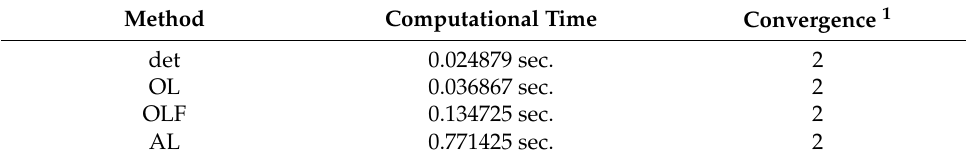
Table 1. Computational aspects of optimal control for the MacRae model Method